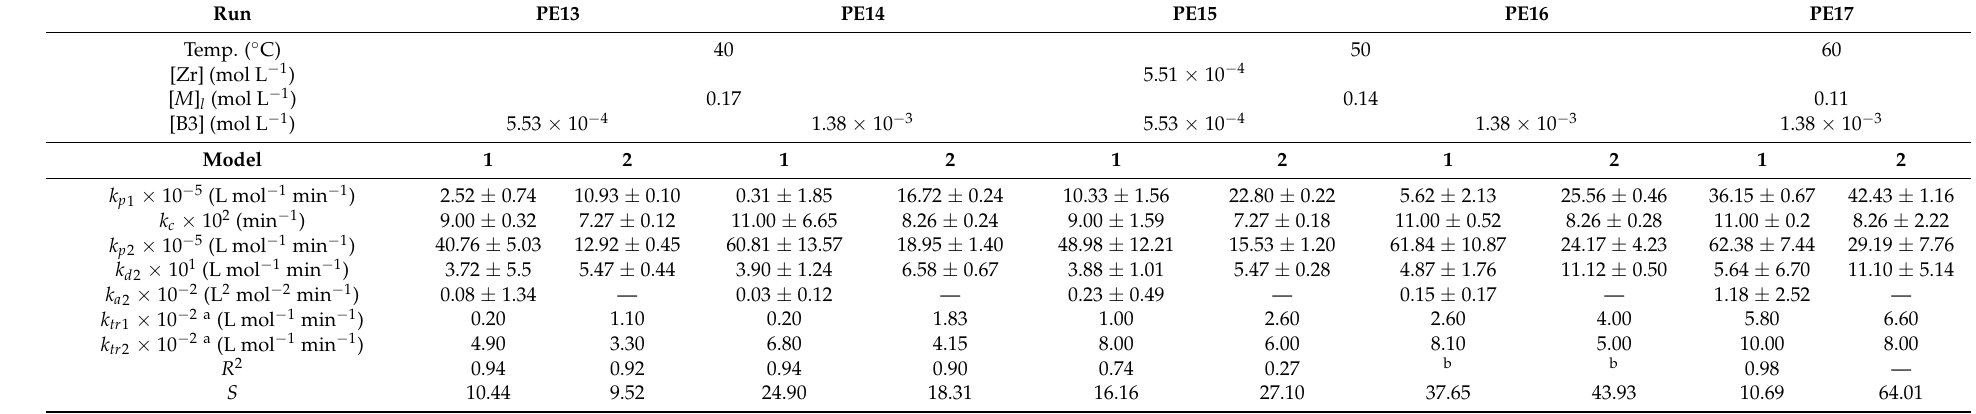
Table 6. Operating conditions, [ M ] l , estimated kinetic rate constants, coefficients of determination ( R 2 ), standard deviation ( S ), and operating pressure P = 150 bar. Run PE13 PE14 PE15 PE16 PE17 Temp. ( ◦